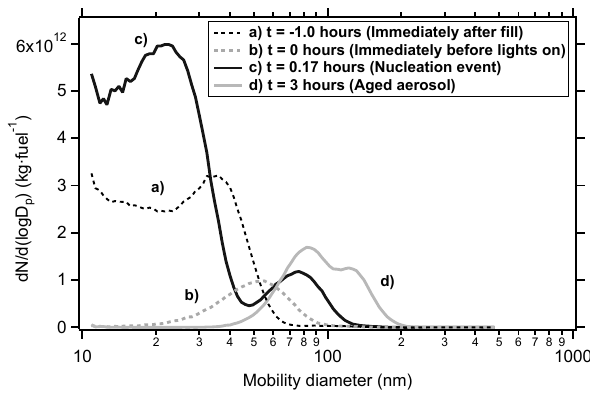
Fig. 3. Size distributions measured (a) immediately after fill, (b) immediately before lights on, (c) shortly after light on (nucleation event) (shortly after lights on), and d ) aged aerosol (after 3h of ox- idation). The data are from a 4% load experiment. The decrease in particle number is due to a combination of coagulation and particle losses to the chamber